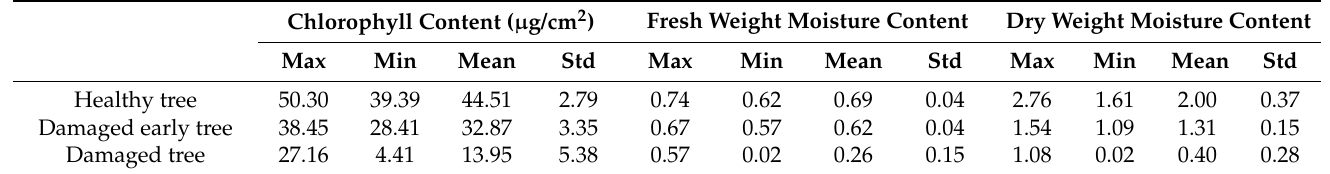
Table 2. Descriptive statistics of biochemical components of different types of sample trees.